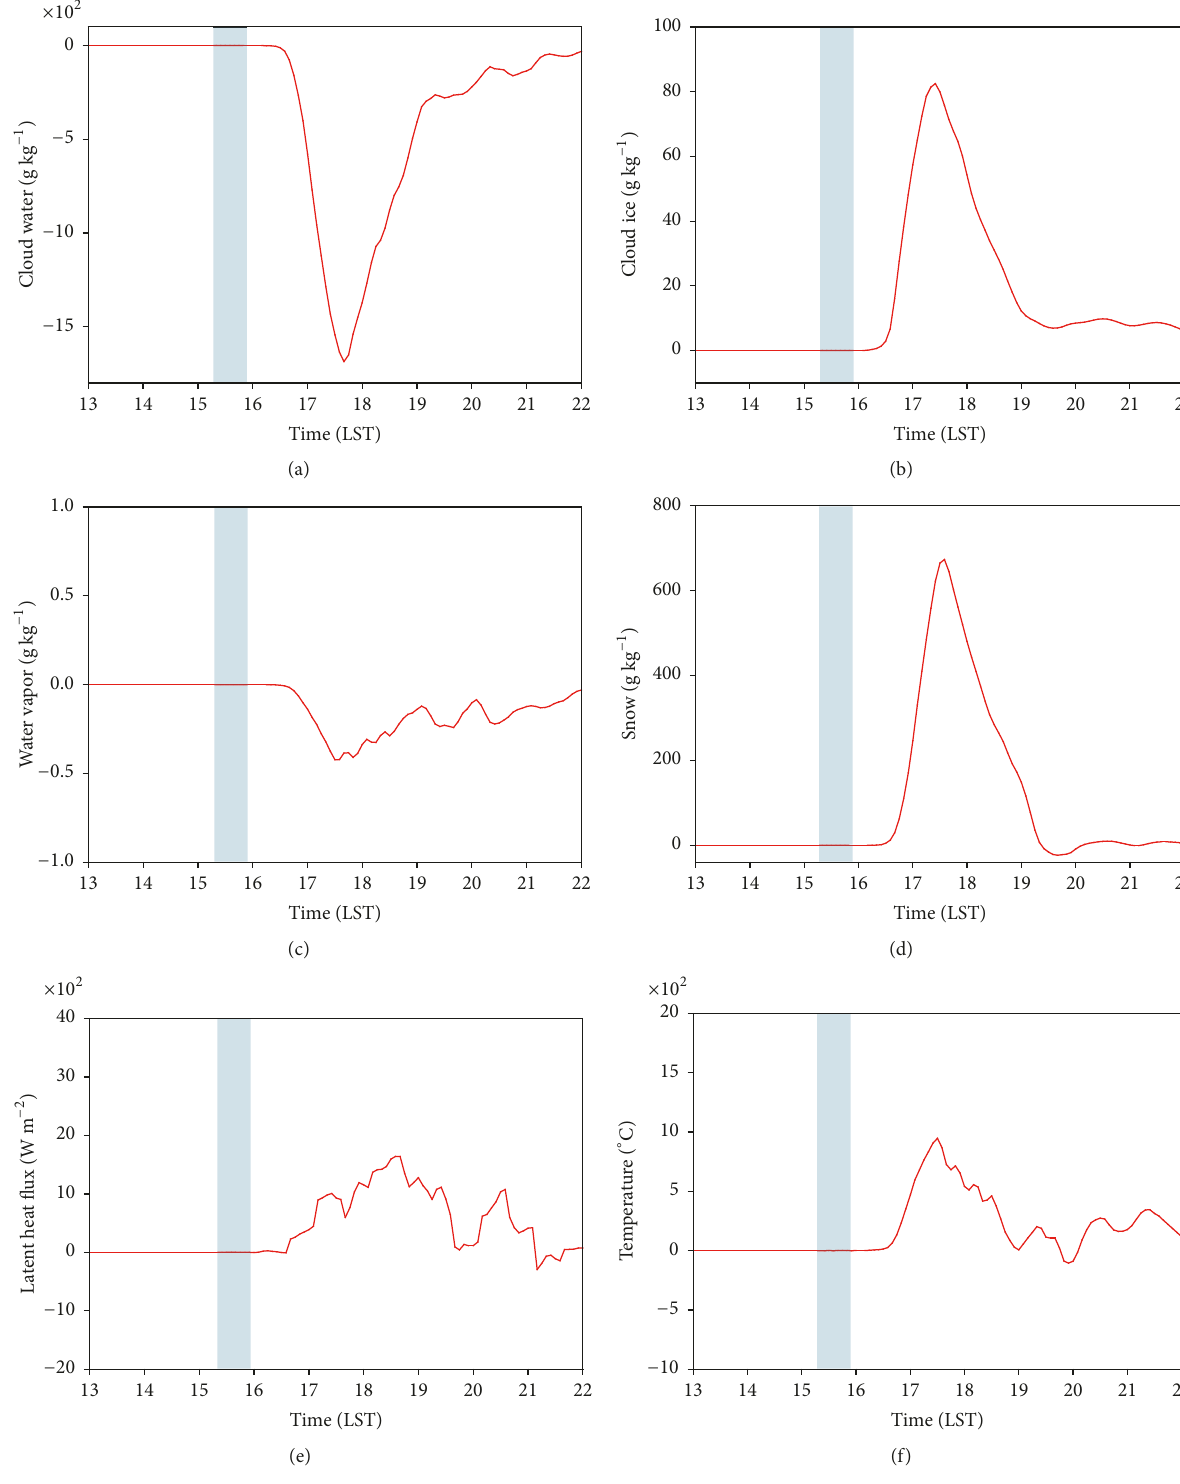
Figure 8: Same as Figure 7 except for the box area in Figure 6(d) in